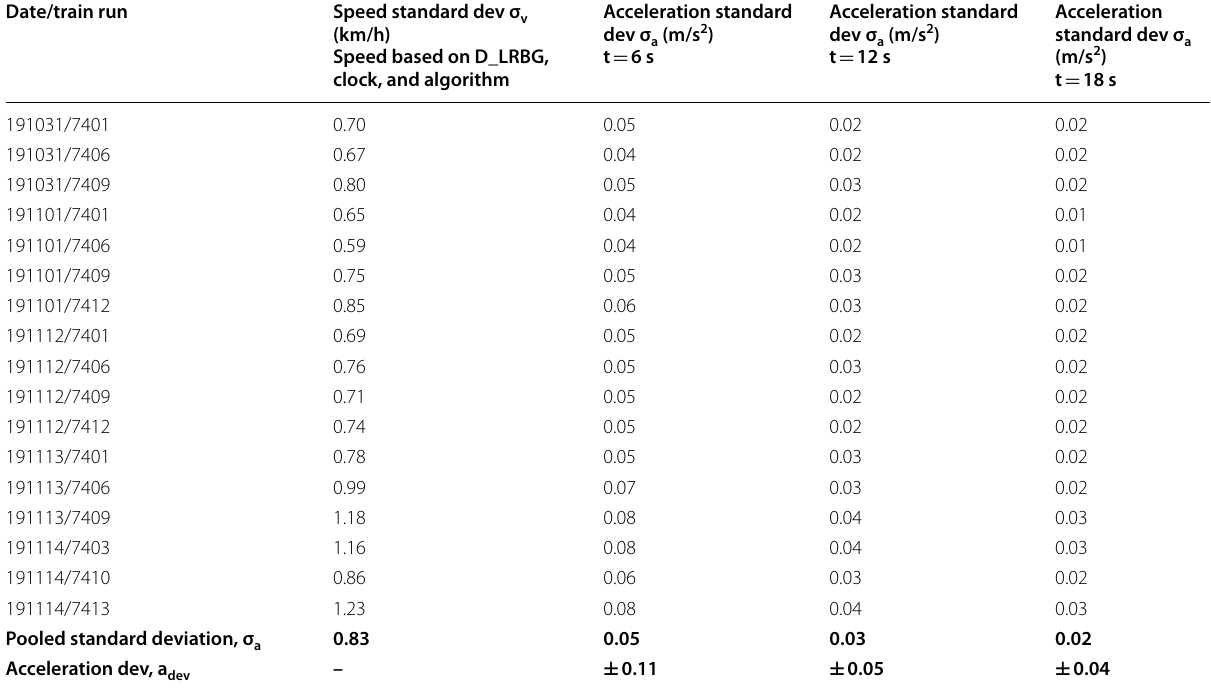
Table 7 Train acceleration validation based on D_LRBG distance, trainborne clock and algorithm (Alternative 3) Date/train run Speed based on D_LRBG, clock, and